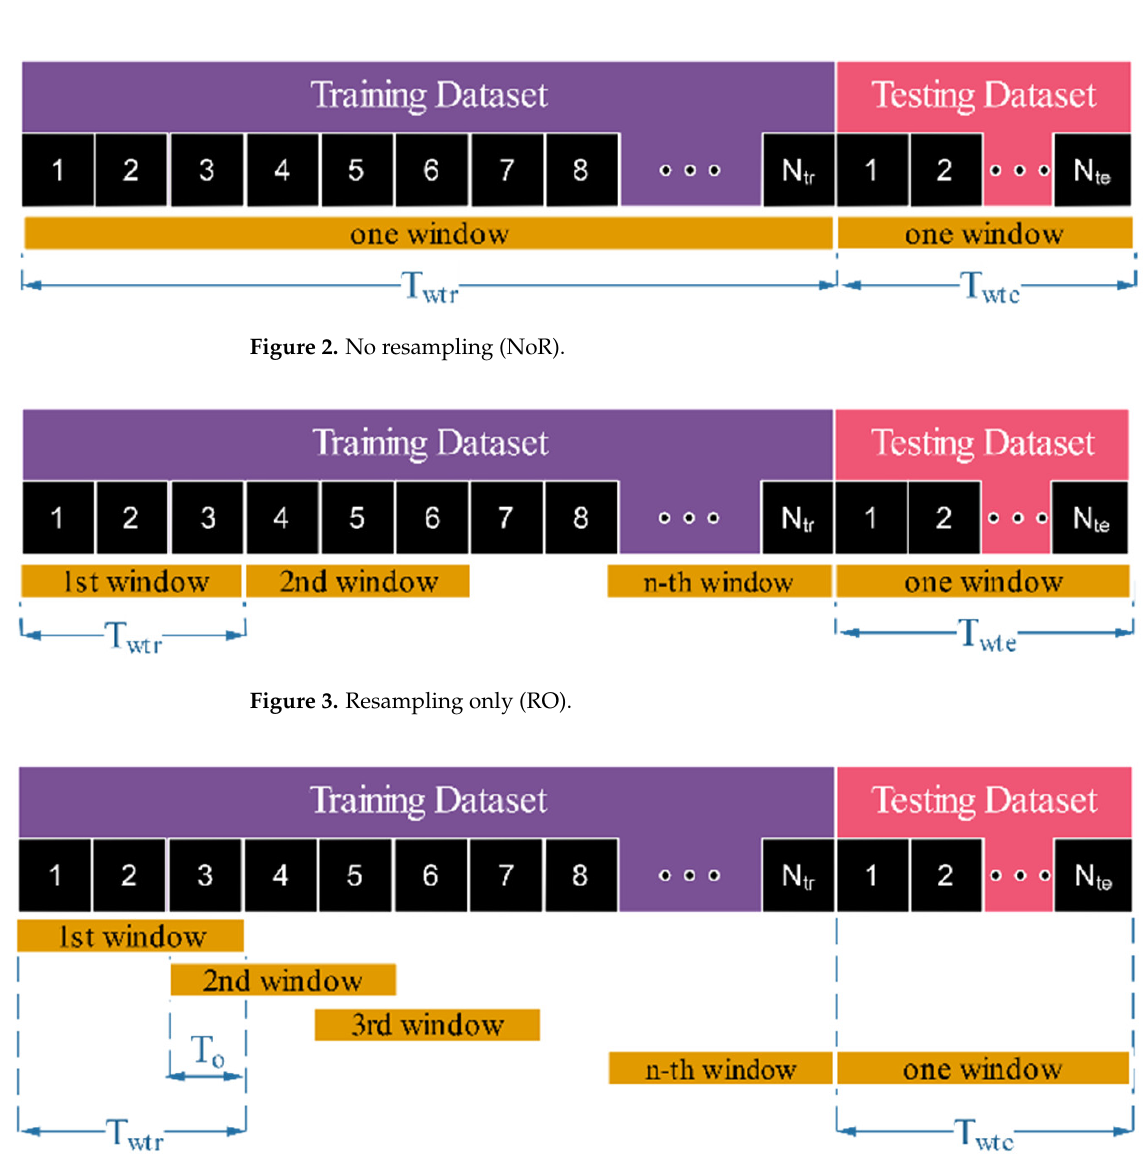
Figure 4. Resampling with overlapping windows (ROW). Table 3. List of resampling scenarios used in the proposed driving fatigue detection framework.